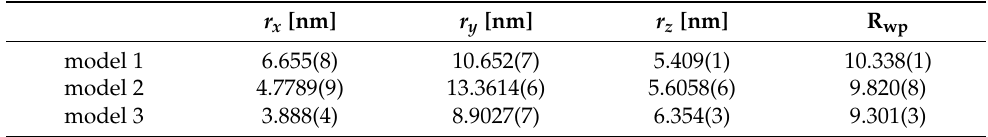
Table 3. Anisotropic crystallite size refinement values in